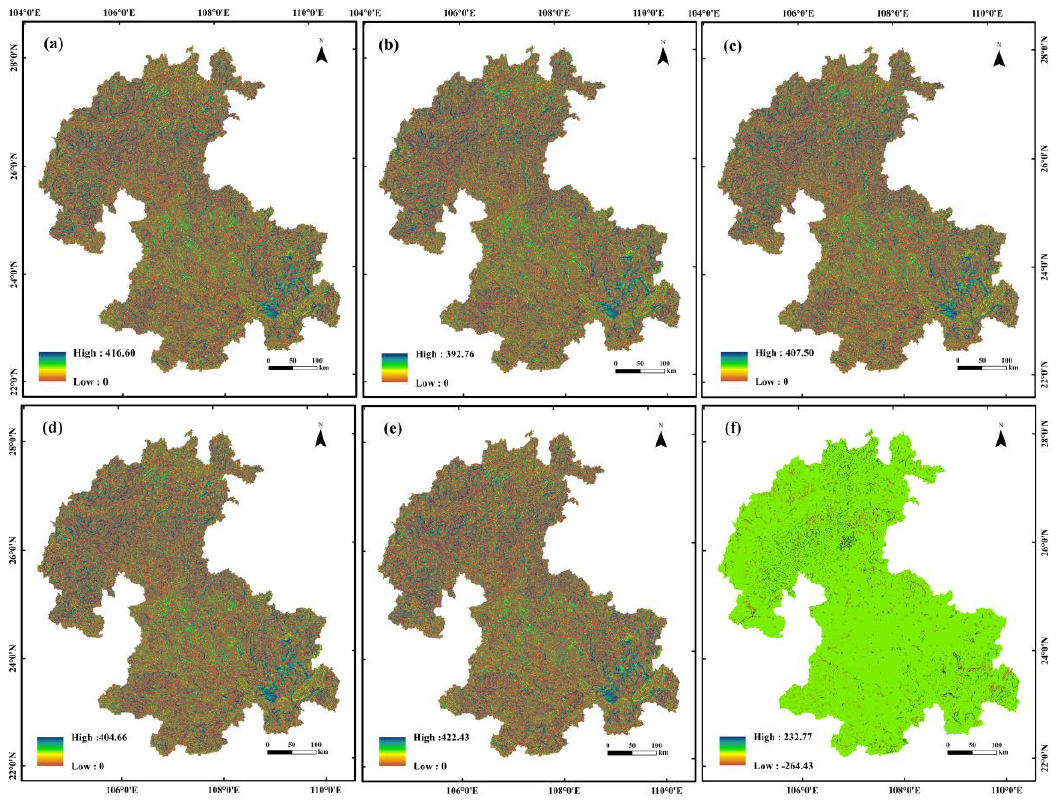
Figure 7. Nutrient retention from 1990 to 2010, ( a ) 1990, ( b ) 1995, ( c ) 2000, ( d ) 2005, and ( e ) 2010, and ( f ) variation in nutrient retention from 1990 to 2010 (all units are in t/km 2 ).